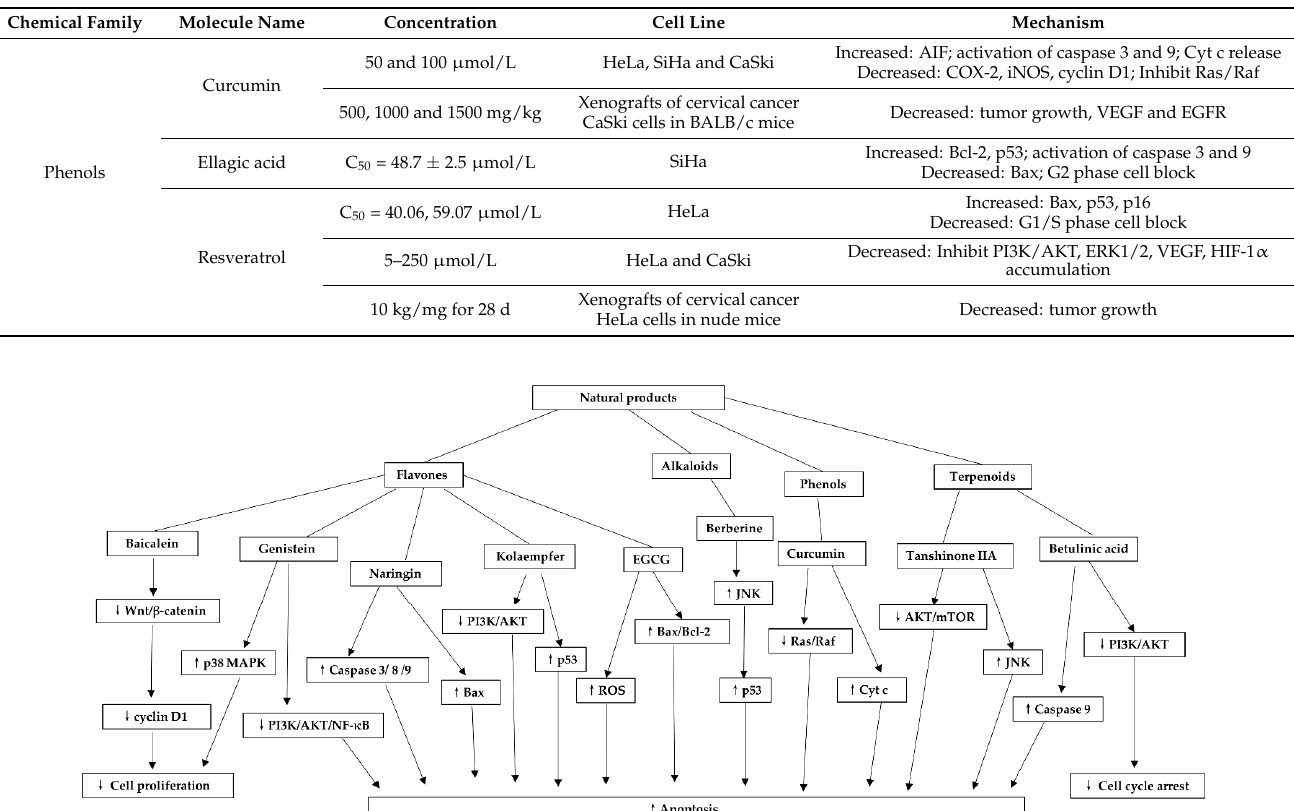
Figure 5. Mechanism of natural products against cervical cancer. Baicalein inhibits Cyclin D1 expression through down- regulation of the Wnt/ β -catenin pathway, which in turn inhibits cell proliferation. Genistein inhibits cell proliferation by activating the p38 MAPK pathway. It also induces apoptosis by inhibiting the PI3K/AKT-NF- κ B pathway, which in turn